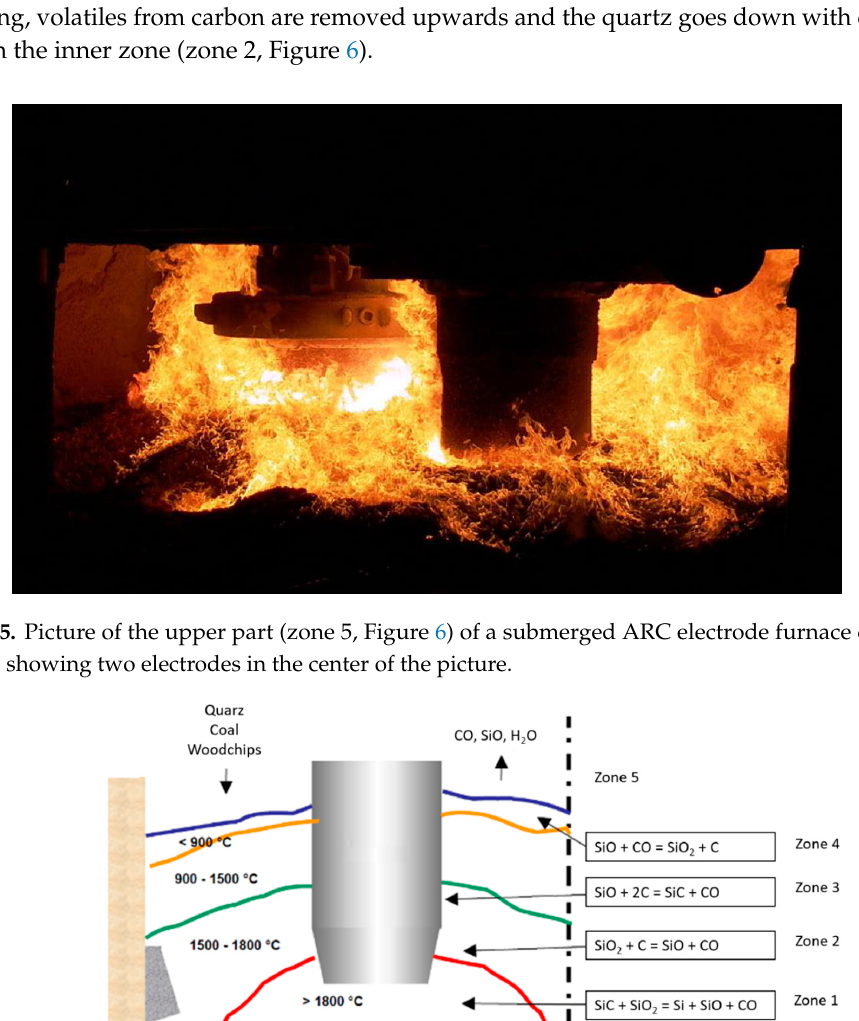
Figure 6. Sketch of the electrode and different zones inside a submerged ARC electrode furnace.